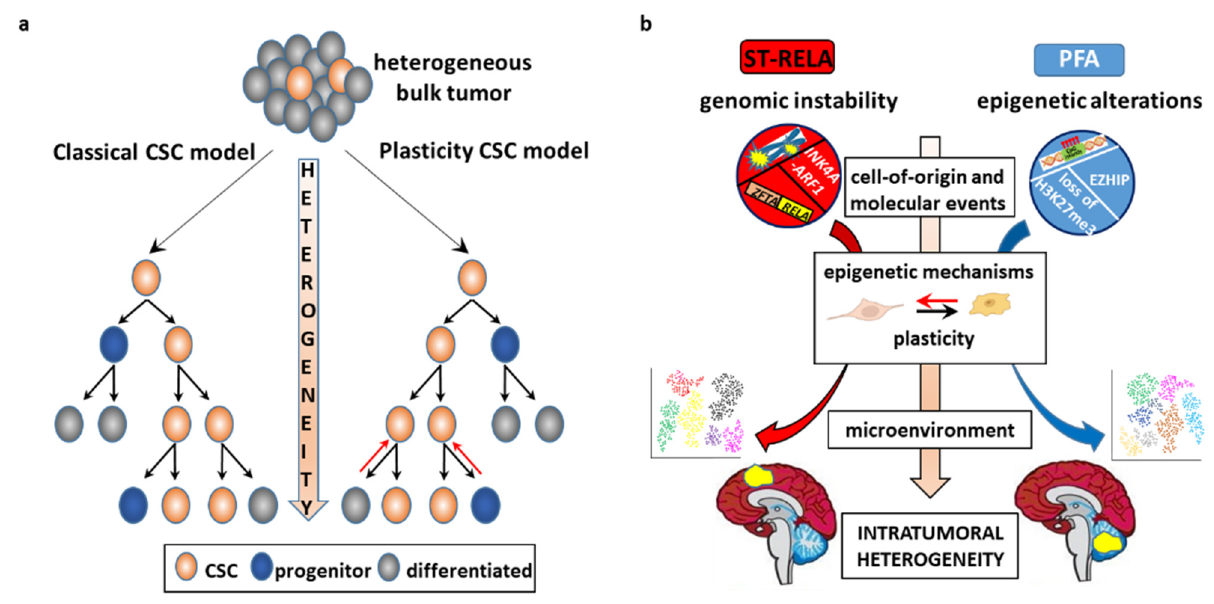
Figure 2. Intra-tumoral heterogeneity (ITH) of EPN in the cancer stem cell (CSC) perspective. ( a ) Schematics of the classical (on the left) and plasticity (on the right) CSC model. The classical CSC model asserts that CSCs are a rare fraction of the bulk tumor, able to self-renew and to differentiate along multiple lineages, driving unidirectional hierarchy of heterogeneous cells. CSC plasticity model proposes that cancer cells can dynamically transition from a CSC state to a non-CSC state and vice versa. Combinatorial dynamics of genetic and epigenetic alterations and distinct microenvironmental contexts engender cell stemness and plasticity, installing ITH. ( b ) CSC model(s) in intra-cranial ependymomagenesis. Molecular events occurring in distinct cells of origin drive ependymomagenesis in the two compartments: genomic instability, leading to chromothripsis, gene fusions, and INK4a-ARF deletions, predominate in ST-RELA, whereas epigenetic factors (e.g., CIMP phenotype, global loss of H3K27me3, EZHIP overexpression) predominate in PFA.